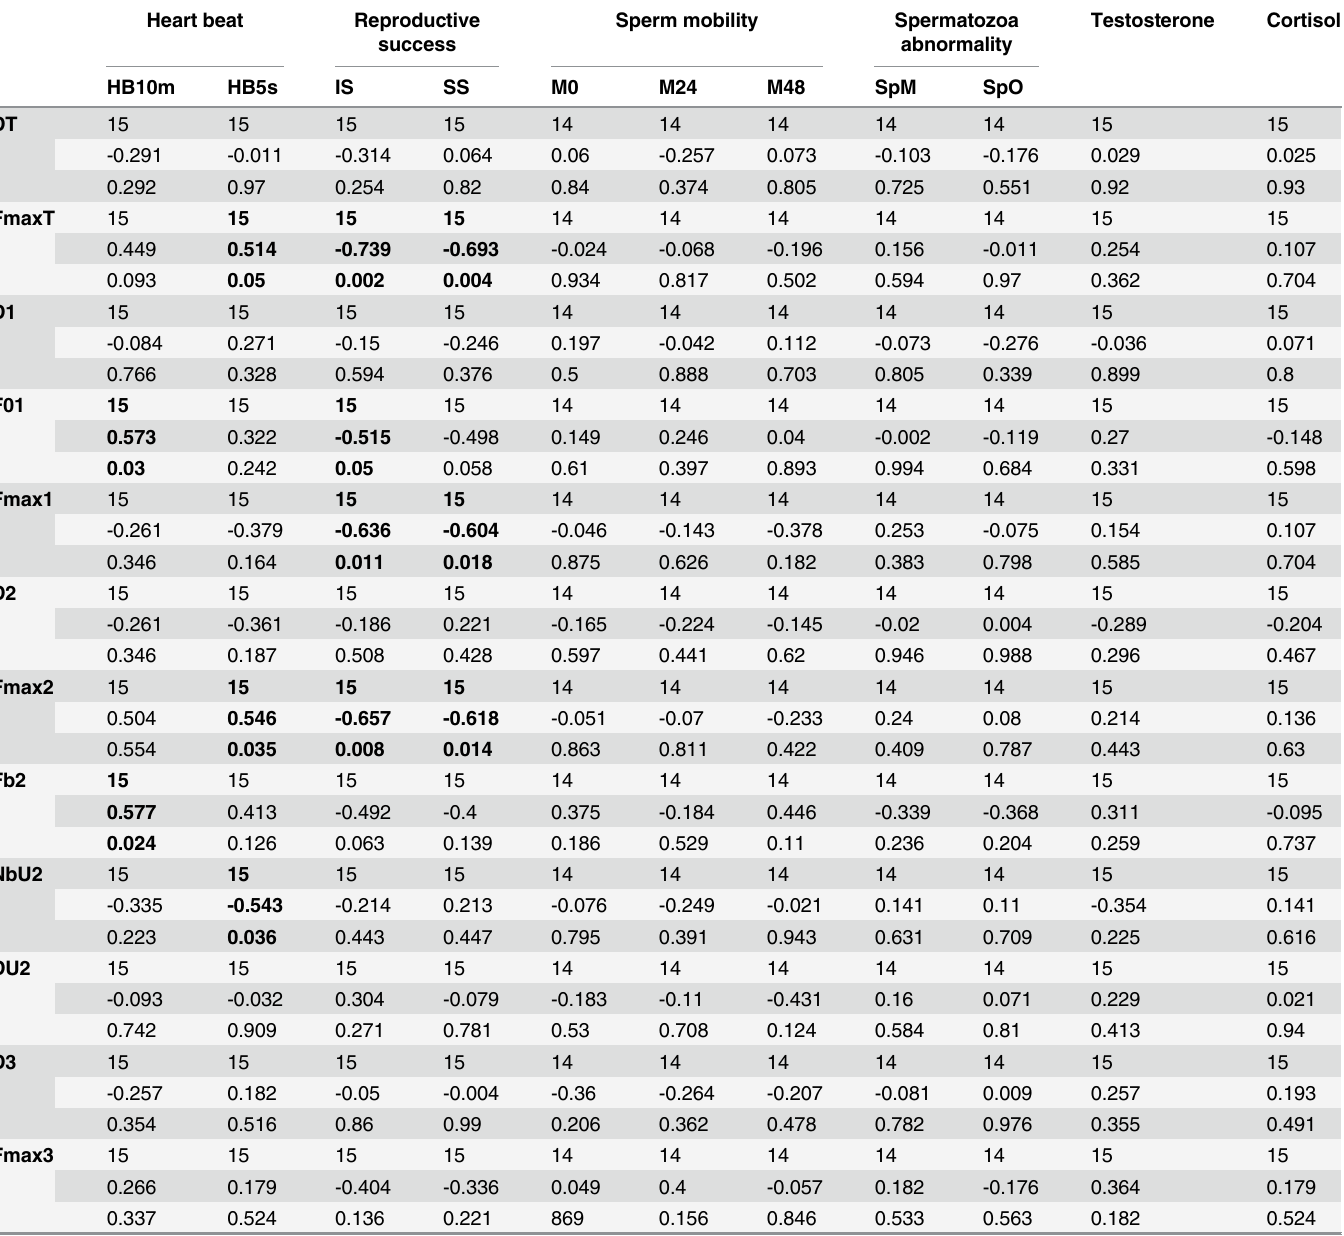
Table 4. Relationships between acoustic and physiological